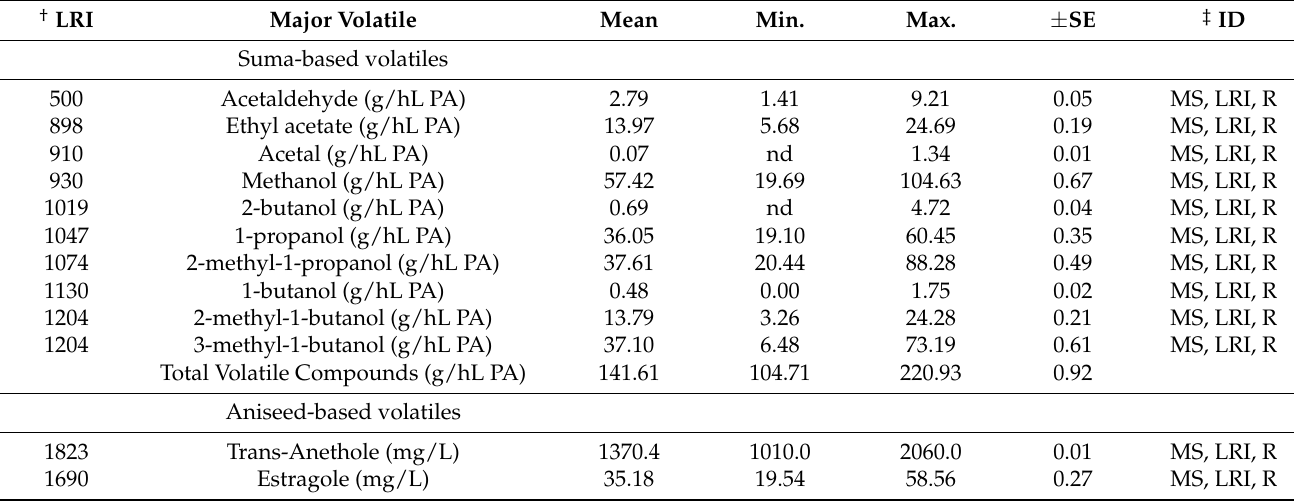
Table 2. Major volatiles in Rakı